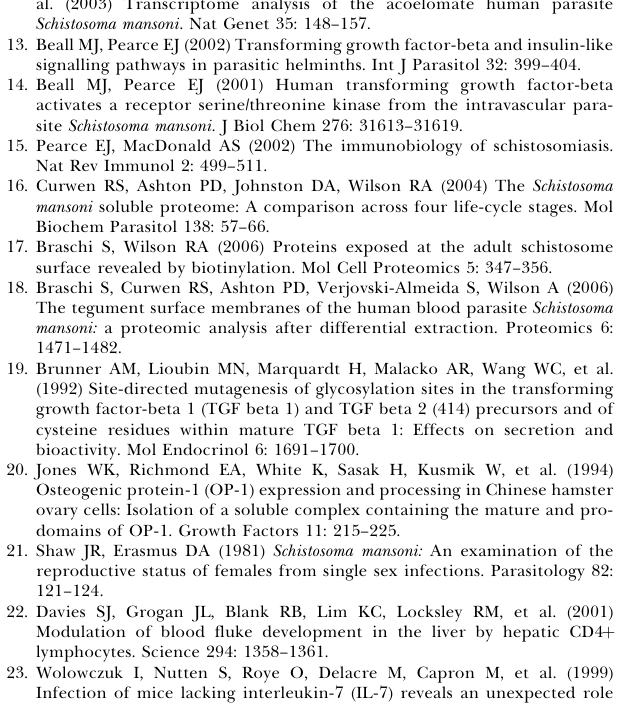
paramyosin as a reference gene for expression. dsRNA treatment is indicated on the x -axis. Data are presented as the mean fold change